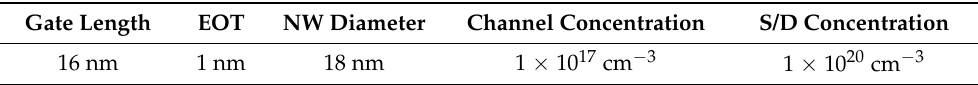
Table 1. Some important parameters of the GAA NW